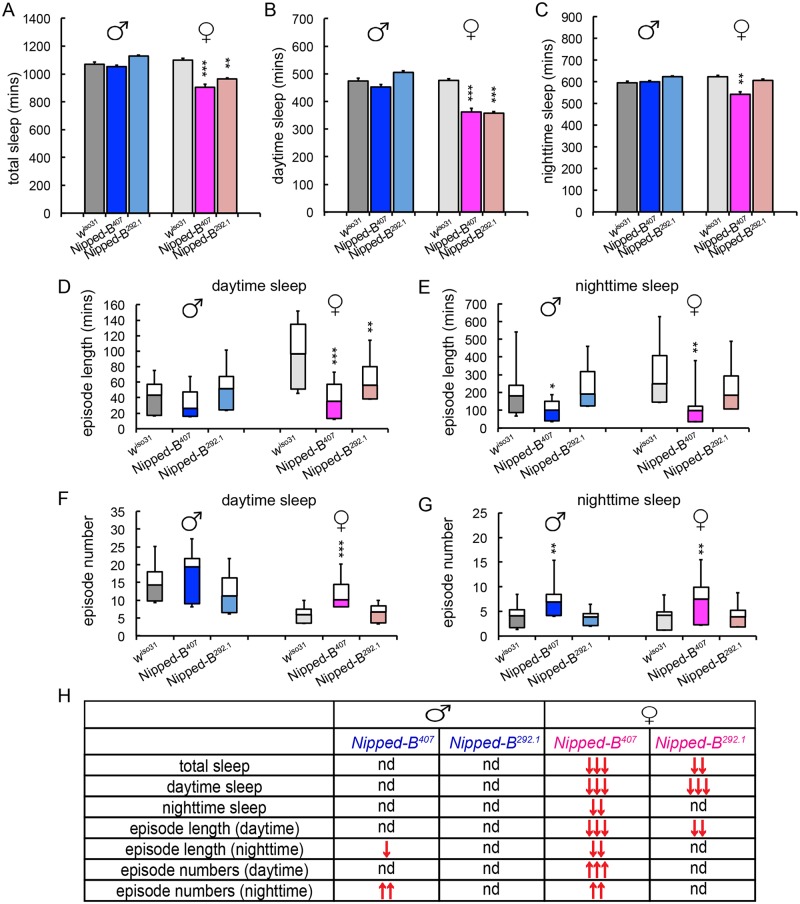

Nipped-B heterozygotes have disrupted sleep patterns.(A-C) Nipped-B heterozygous females, but not males, sleep less than w
iso31 flies as shown in amounts of total sleep (A), daytime sleep (B), and nighttime sleep (C). (D-G) In general, shortened sleep episodes seen in Nipped-B
407 male and female mutants are coupled with increased numbers of sleep episodes, both during daytime sleep and nighttime sleep. The lengths of sleep episodes of Nipped-B
292.1 females are not significantly different from w
iso31 flies. (H) Summary of statistical differences seen in Nipped-B mutants and w
iso31 controls. One-way ANOVA post hoc Tukey tests were used to determine statistical difference in the sleep parameters; *, p<0.05; **, p<0.01; ***, p<0.001. ↑ and ↓ indicate more or less/fewer than controls.